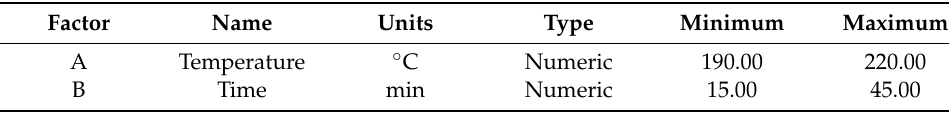
Table 2. Range of the variables for the experimental design.